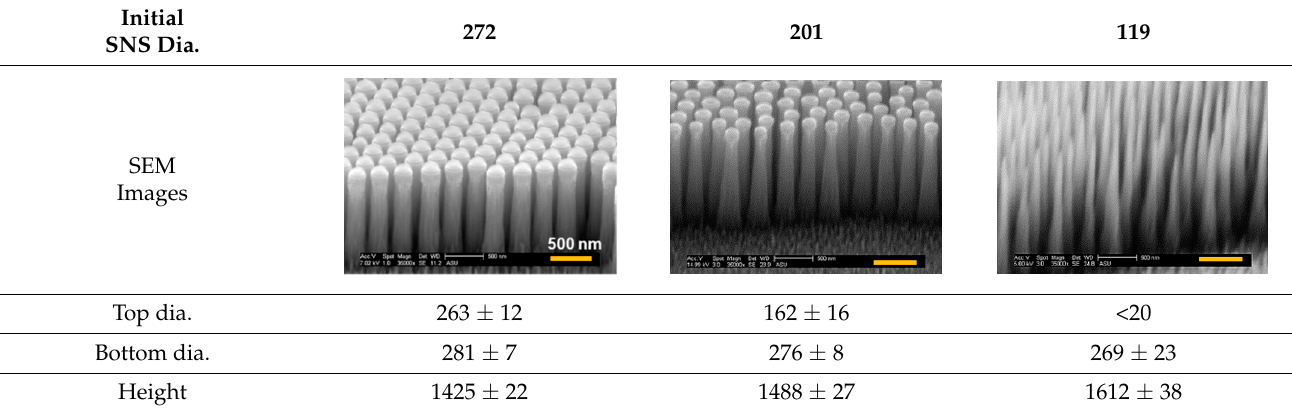
Table 2. Measured top and bottom diameters and heights of fabricated Si NPs with different initial SNS mask size (unit: nm). Initial SNS Dia SNS Dia.